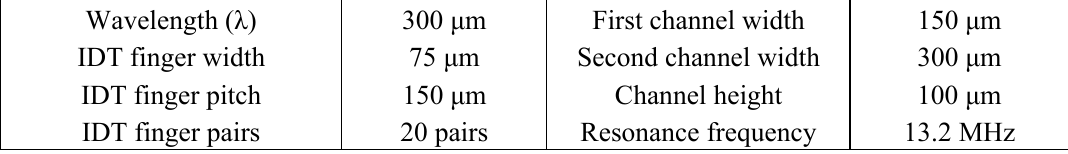
Table 1. Design parameters used for the size-based separation experiments.